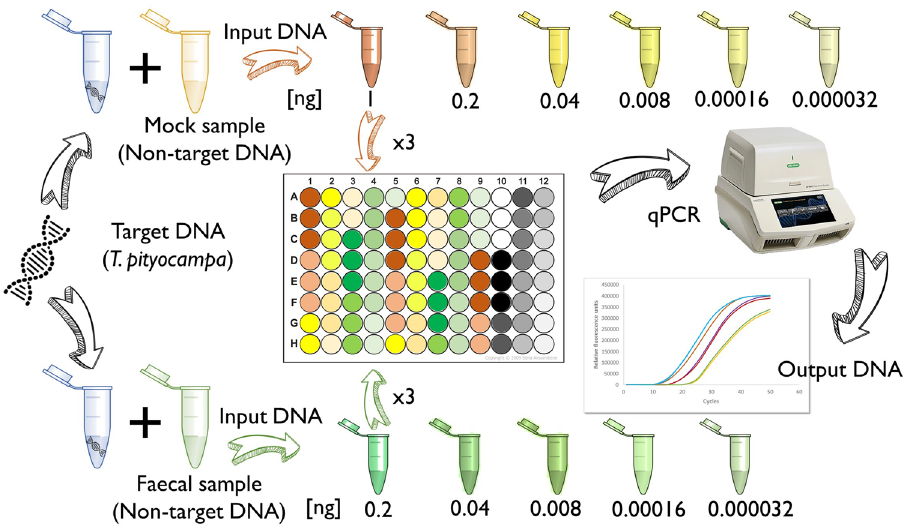
Figure 1. Overview of the experimental workflow for the quantitative assessment of